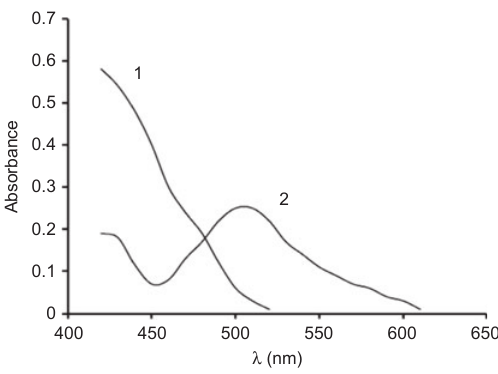
Figure 1 Absorption spectra in Dowex 1 × 1 resin phase: (1)-Nitroso R salt, 20 µ mol/g resin; (2)-Rh(III)-NRS complex, 2.25 µ mol/g of resin.